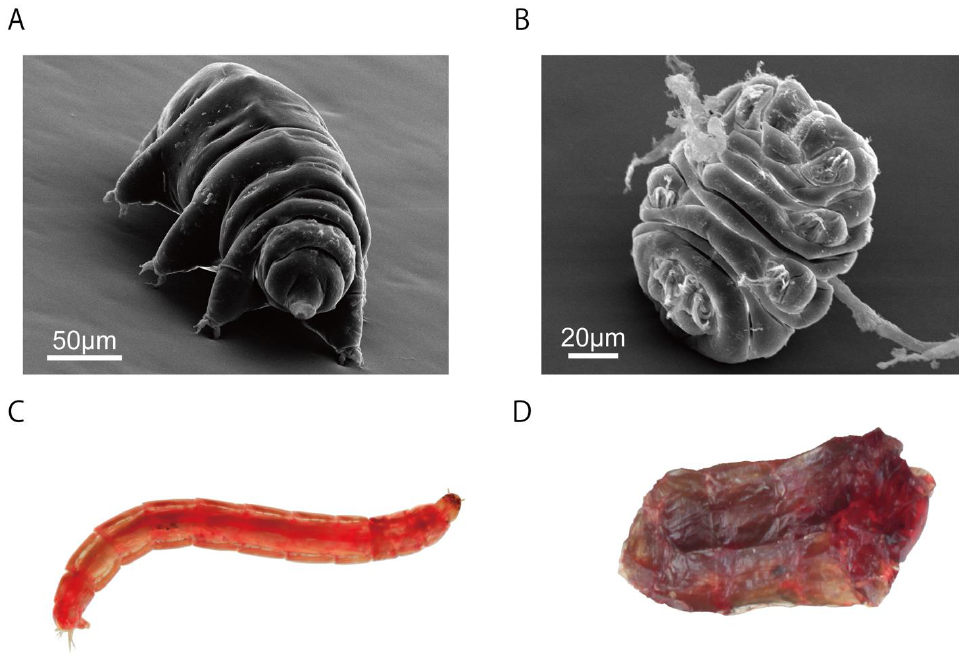
Figure 2. Tardigrades and chironomids. Images of Macrobiotus shonaicus ( A , B ) and Polypedilum vanderplanki ( C , D ) in the active state ( A , C ) and anhydrobiotic state ( B , D ). Images by Kenta Sugiura ( A , B ) and Gusev et al., 2014 ( C , D ) [114] .